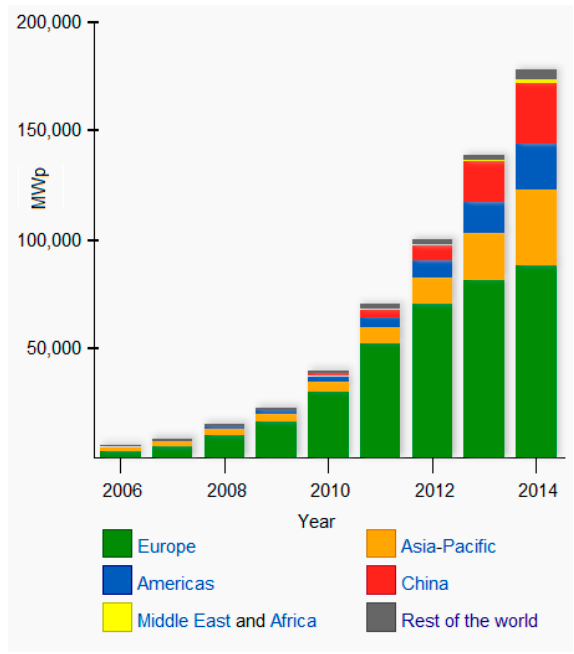
Figure 1. Global growth of solar energy [12].